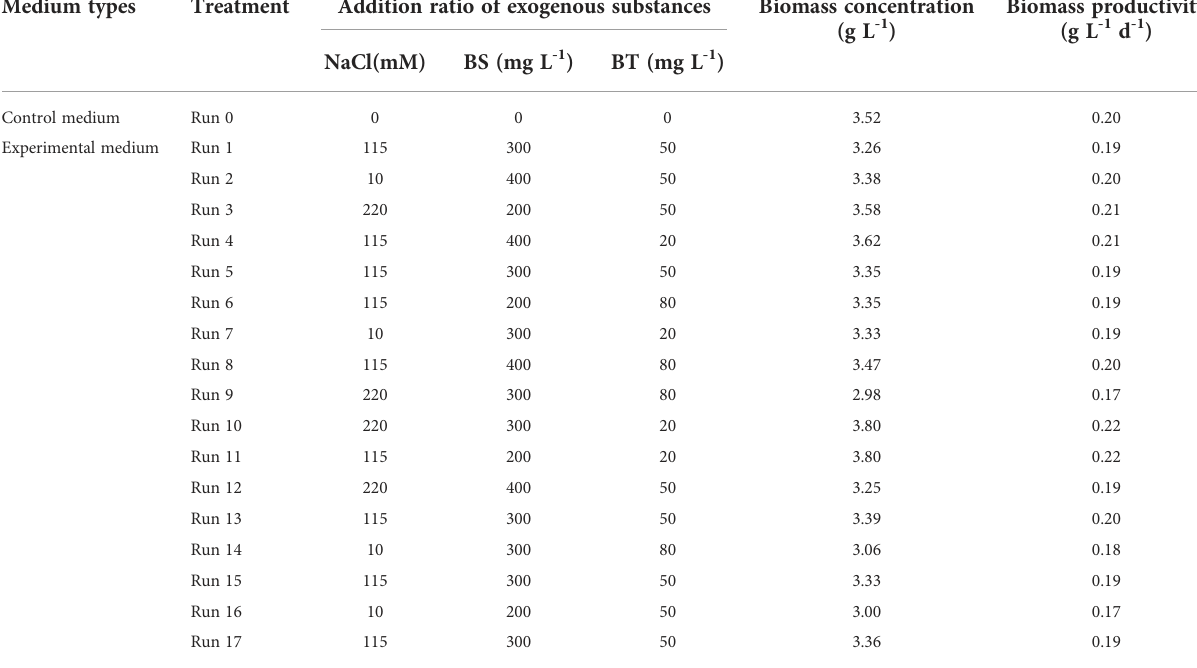
TABLE 4 Comparison of biomass concentration and productivity among the different treatments.